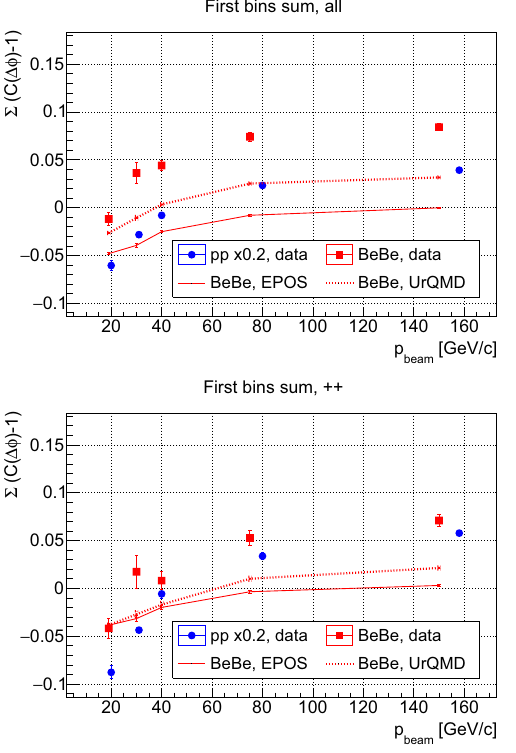
Fig. 15 The sum of two-particle correlation function C ((cid:2)η,(cid:2)φ) in the (cid:2)φ region [ 0 ,π/ 2 ) and (cid:2)η ∈ [ 0 , 0 . 5 ) for different charge combi- nations. Top left picture for all charge pairs, top right for unlike-sign, bottomleftforpositivechargedpairs,bottomrightfornegativecharged.